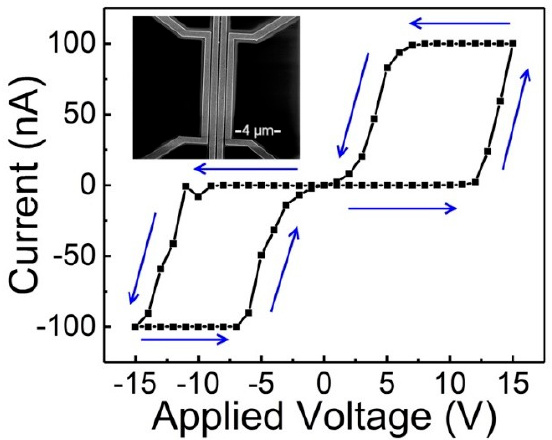
Figure 5. The conductance change with applied voltage of a 20 nm [Fe{H 2 B(pz) 2 } 2 (bipy)] thin film deposited on top of a uniform croconic acid thin film showing a loss of nonvolatility. Longitudinal voltage was applied on different junctions and the measurement was taken at room temperature, and the device schematic is shown in the inset of Figure 5.